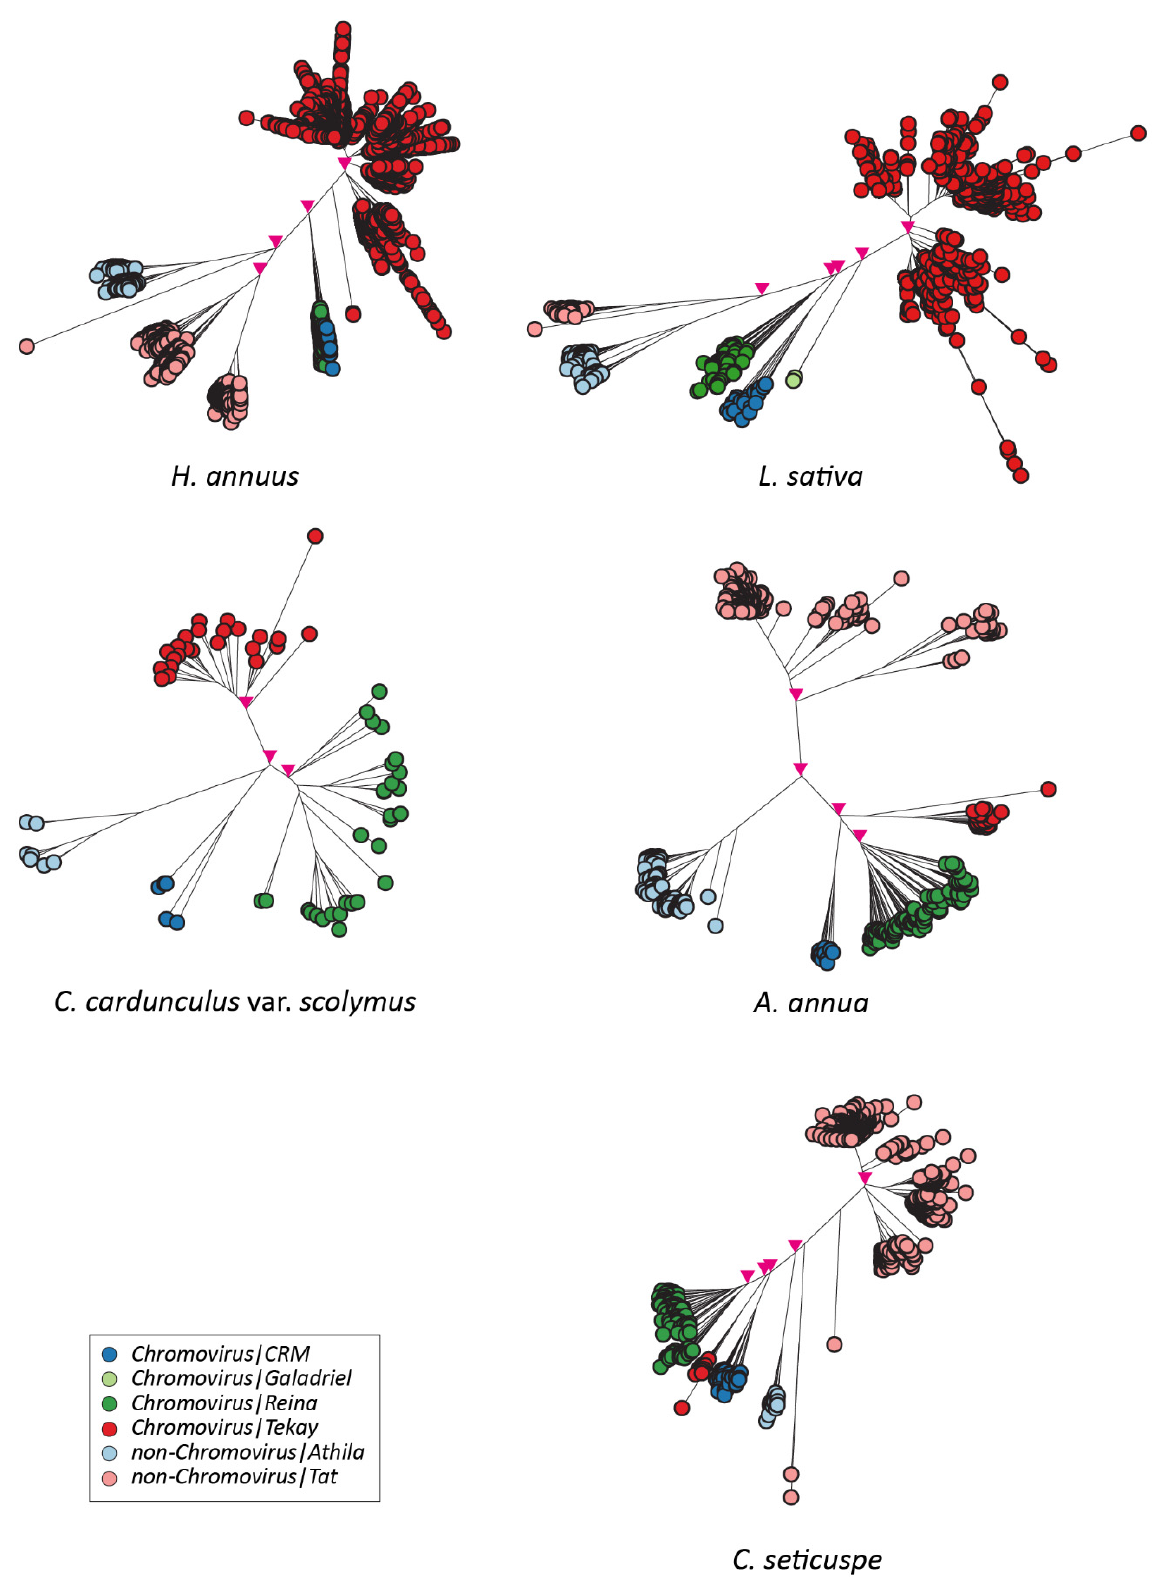
Figure 5. Phylogenetic trees of the LTR-REs of the Gypsy superfamily in individual species. The main nodes (bootstrap values > 0.6) separating the lineages are marked with pink triangles.